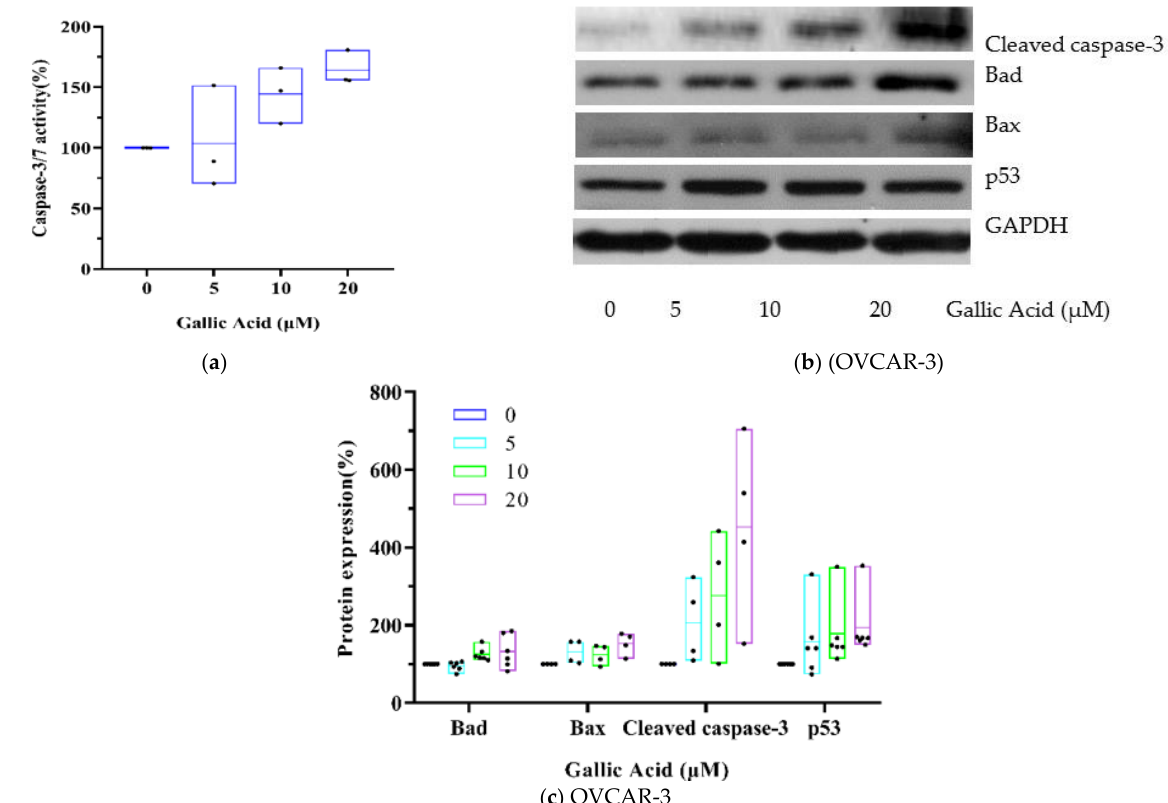
Figure 3. GA induces OVCAR-3 apoptosis by activating p53-dependent signaling. ( a ) Evaluation of Caspase 3/7 activity after 48 h exposure with GA. ( b ) Western blot image. ( c ) Protein expression quantization of Bad, Bax, cleaved caspase-3 and p53.